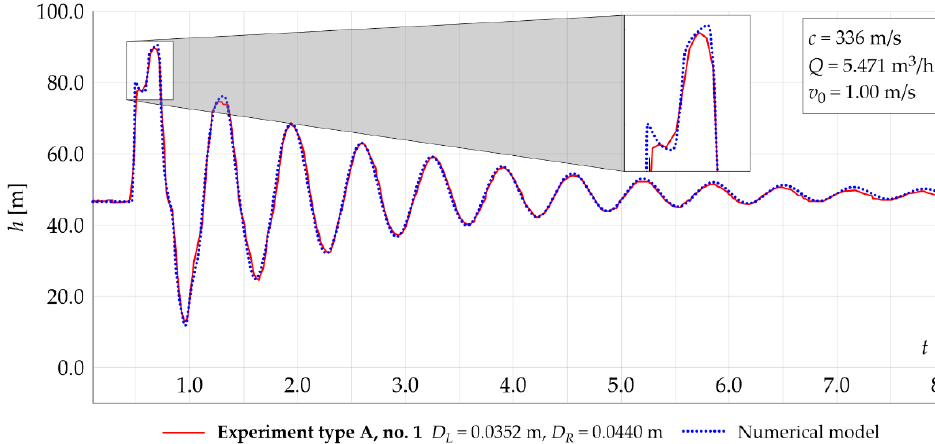
Figure 4. Calculated and observed pressure oscillations during experiment no. 1.